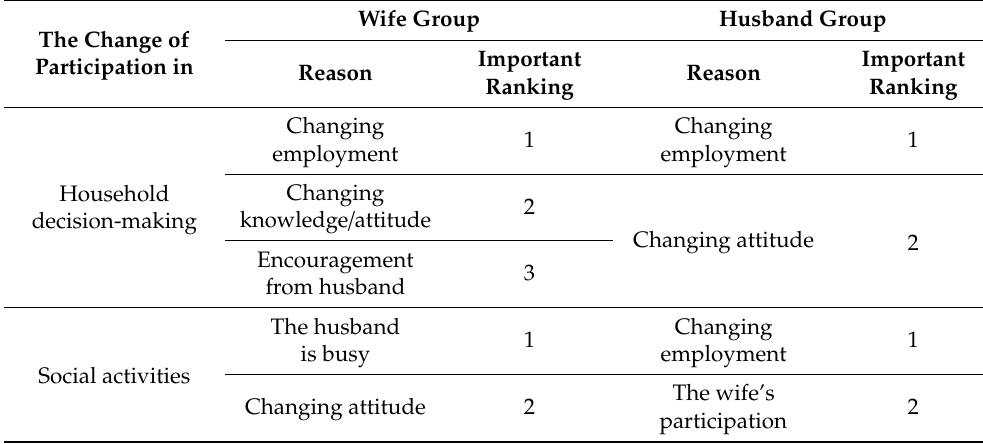
Important Ranking 1 1